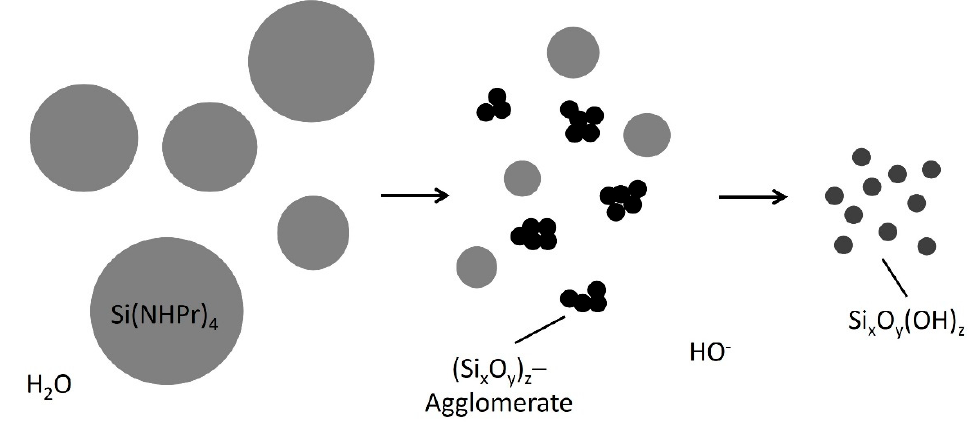
Figure 3. Schematic representation of the reaction of tetra( n -propylamino)silane with water, modified from [68,70].